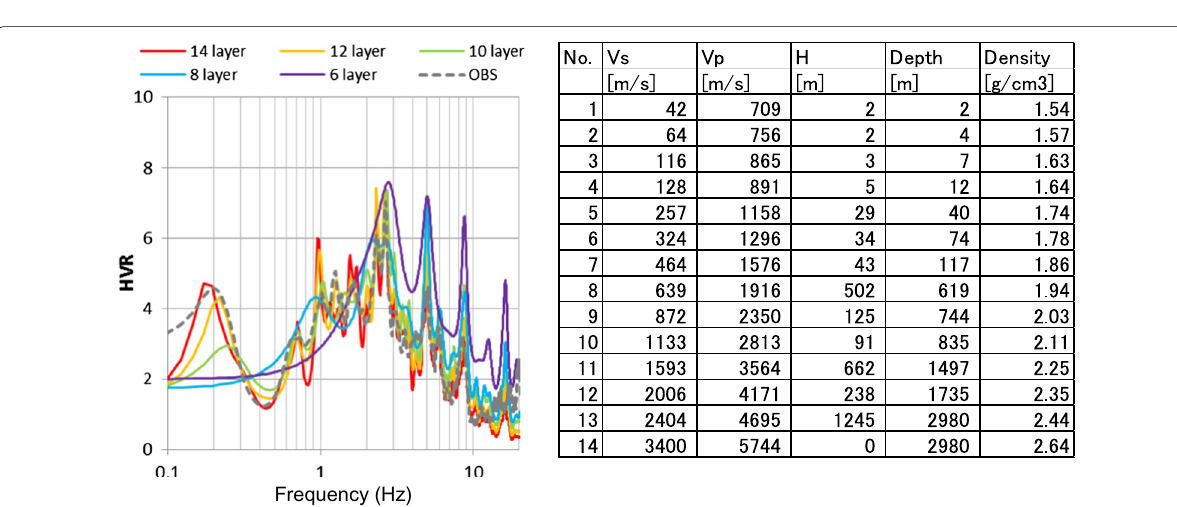
(5) EMR = earthquke HVR / microtremor HVR.